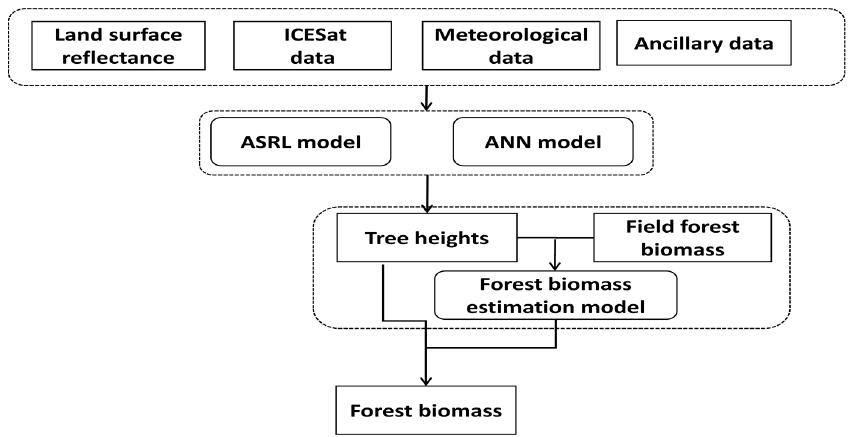
Figure 2. The approach total flowchart of this